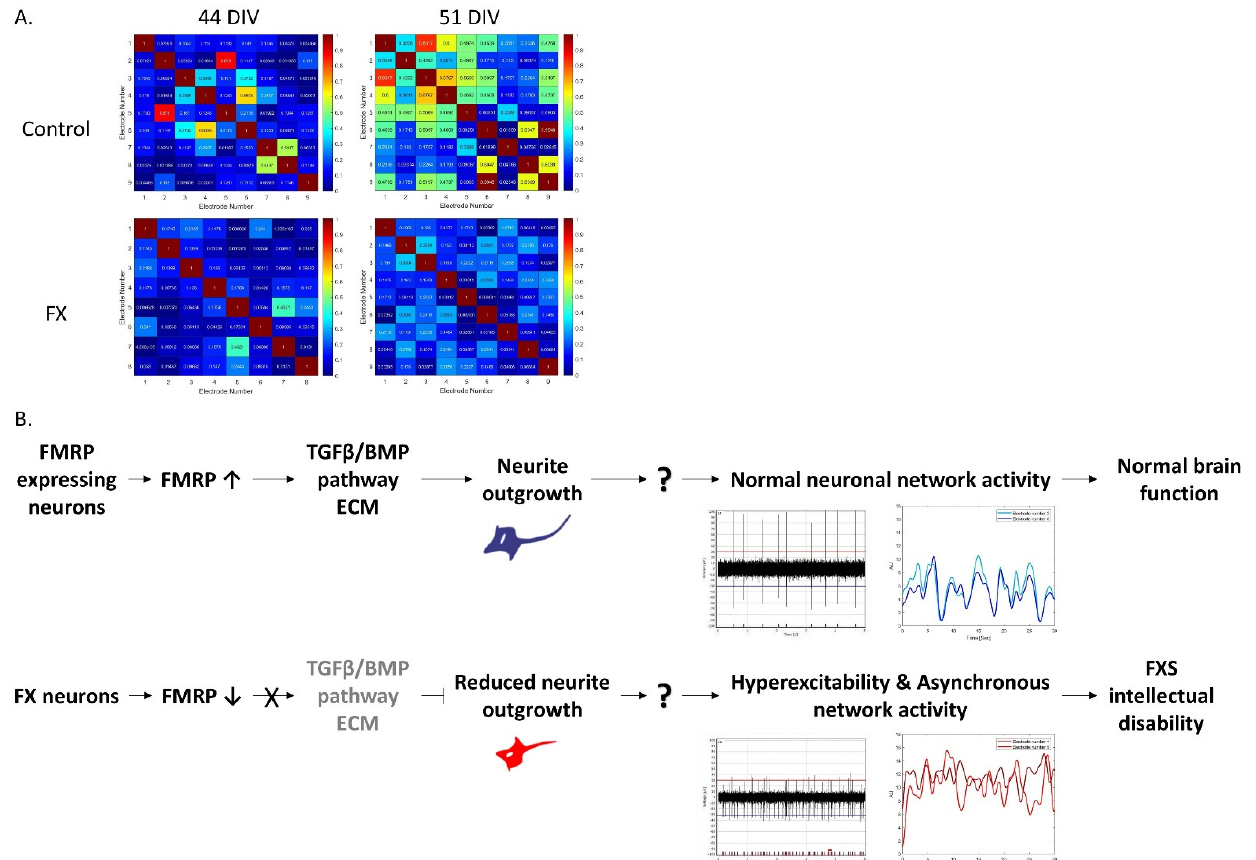
Figure 6. Suggested mechanism by which FMR1 inactivation regulates the impaired functional connectivity underlying Fragile X syndrome. ( A ) Neurons were plated, measured, and analyzed by multielectrode array recordings and data analyses were performed as previously described in Gildin et al., 2022 [24]. These heatmaps summarize cross-correlation among all multielectrode array active electrodes ( ≥ 15 spikes/min) of WT (top) and FX (bottom) derived neurons at 44 DIV (left) and 51 DIV (right). The panel ranges from high synchrony/high cross-correlation among neurons (red), to